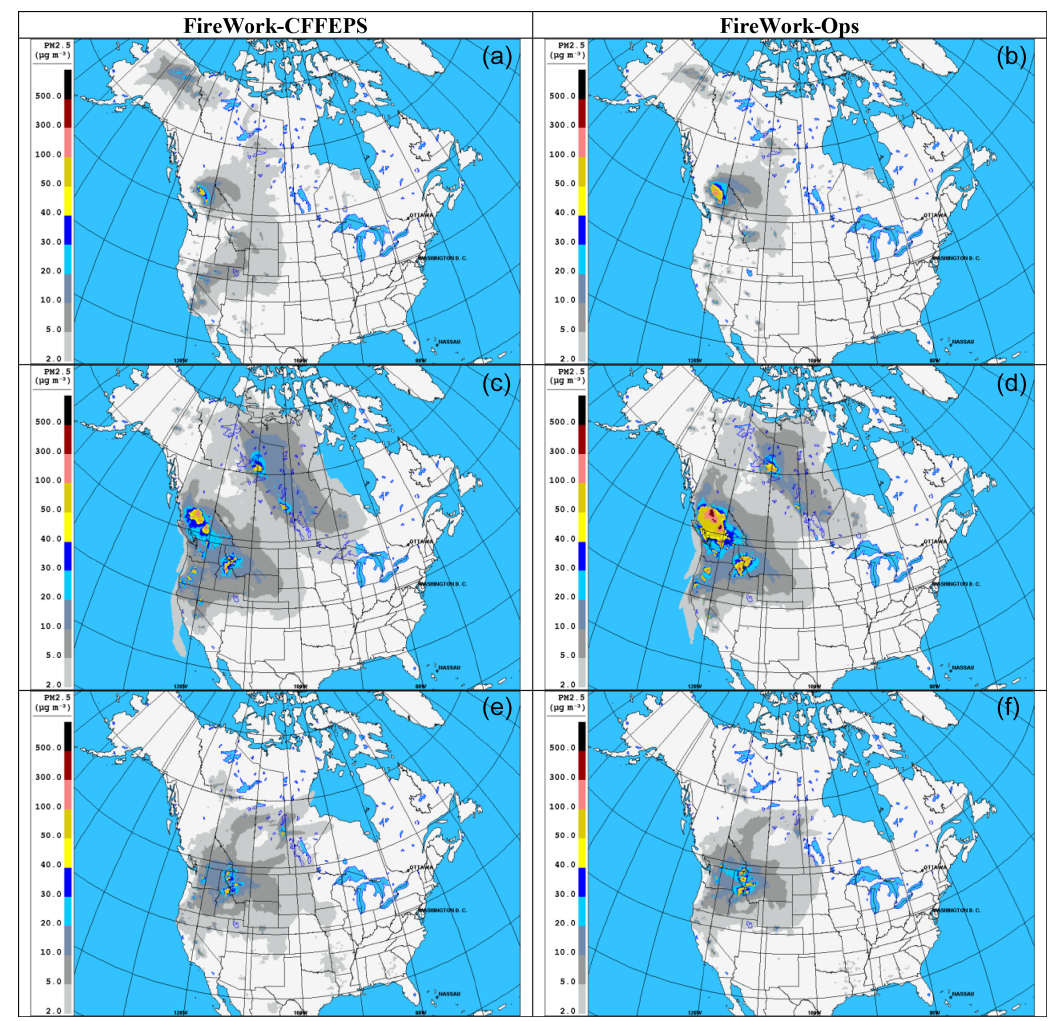
Figure 7. Mean monthly surface fire PM 2 . 5 concentrations (µgm − 3 ) from FireWork–CFFEPS (a, c, e) and FireWork-Ops (b, d, f) for July (a, b) , August (c, d) , and September (e, f)